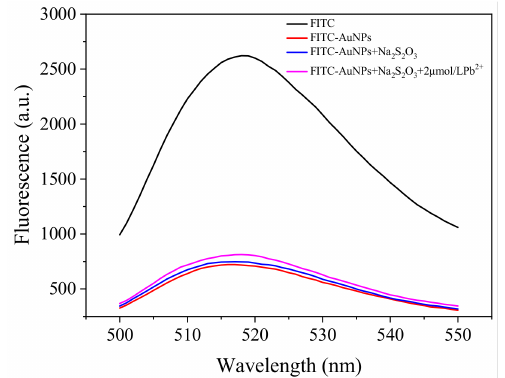
Figure 3. Fluorescence spectra of the